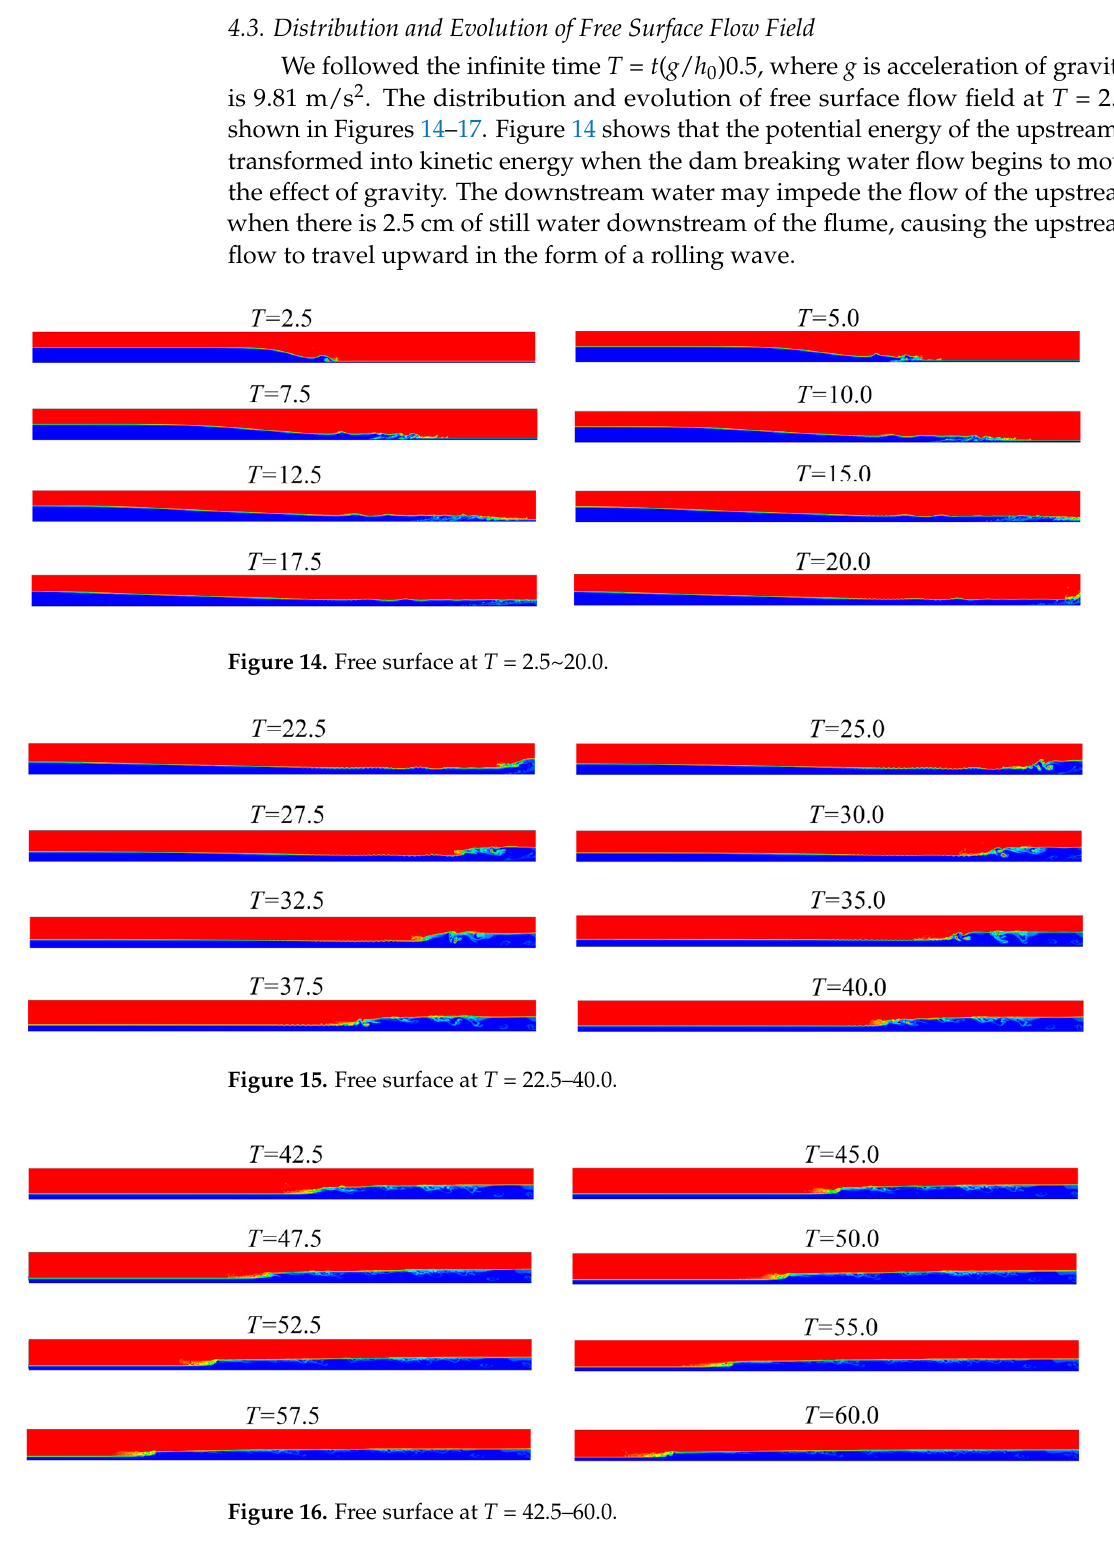
Figure 13. Distribution of an upstream water column and a downstream wet bed in the initial state.